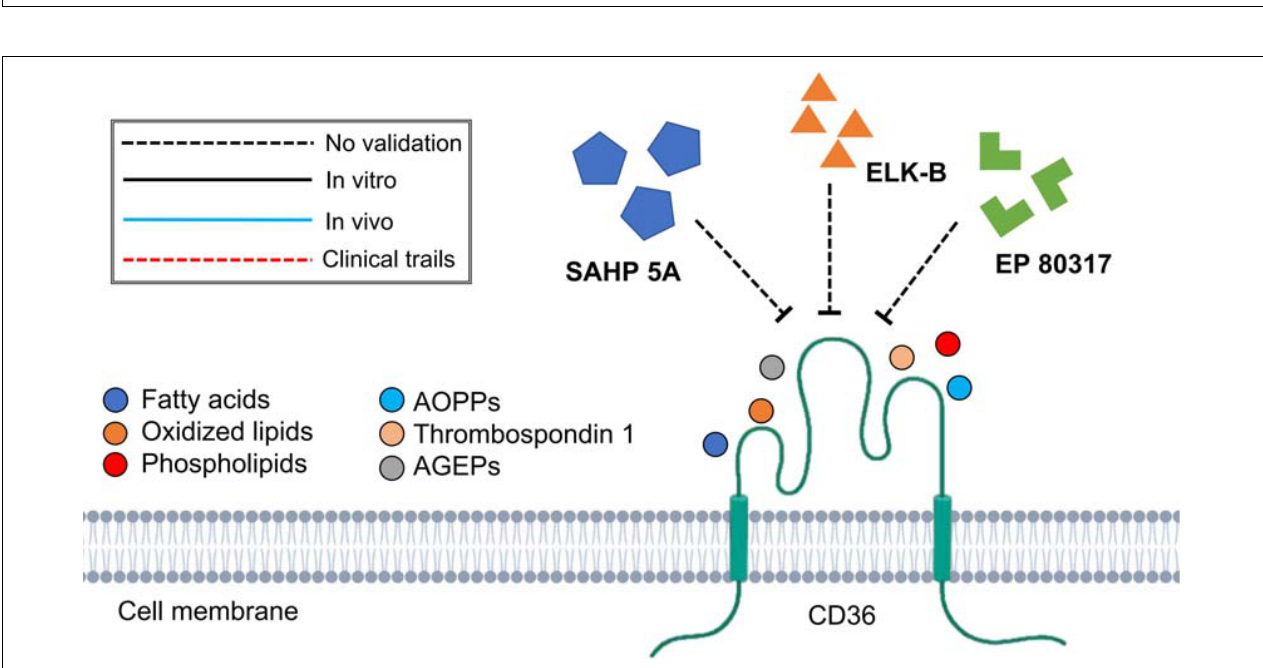
FIGURE 5 | Schematic graph showing potential antifibrotic therapies targeting CD36. (AOPPs, advanced oxidative protein products; AGEPs, advanced glycation end products; SAHP 5A, synthetic amphipathic helical peptides 5A).